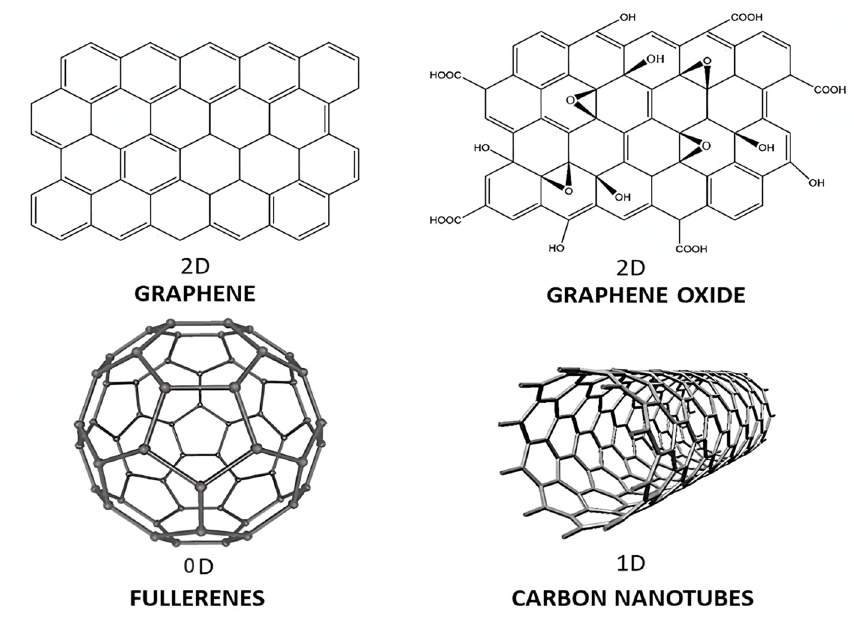
Figure 4. Representation of the structure of carbon-based nanomaterials: 2D graphene (G) and graphene oxide (GO), 0D fullerenes and 1D carbon nanotubes (CNTs).